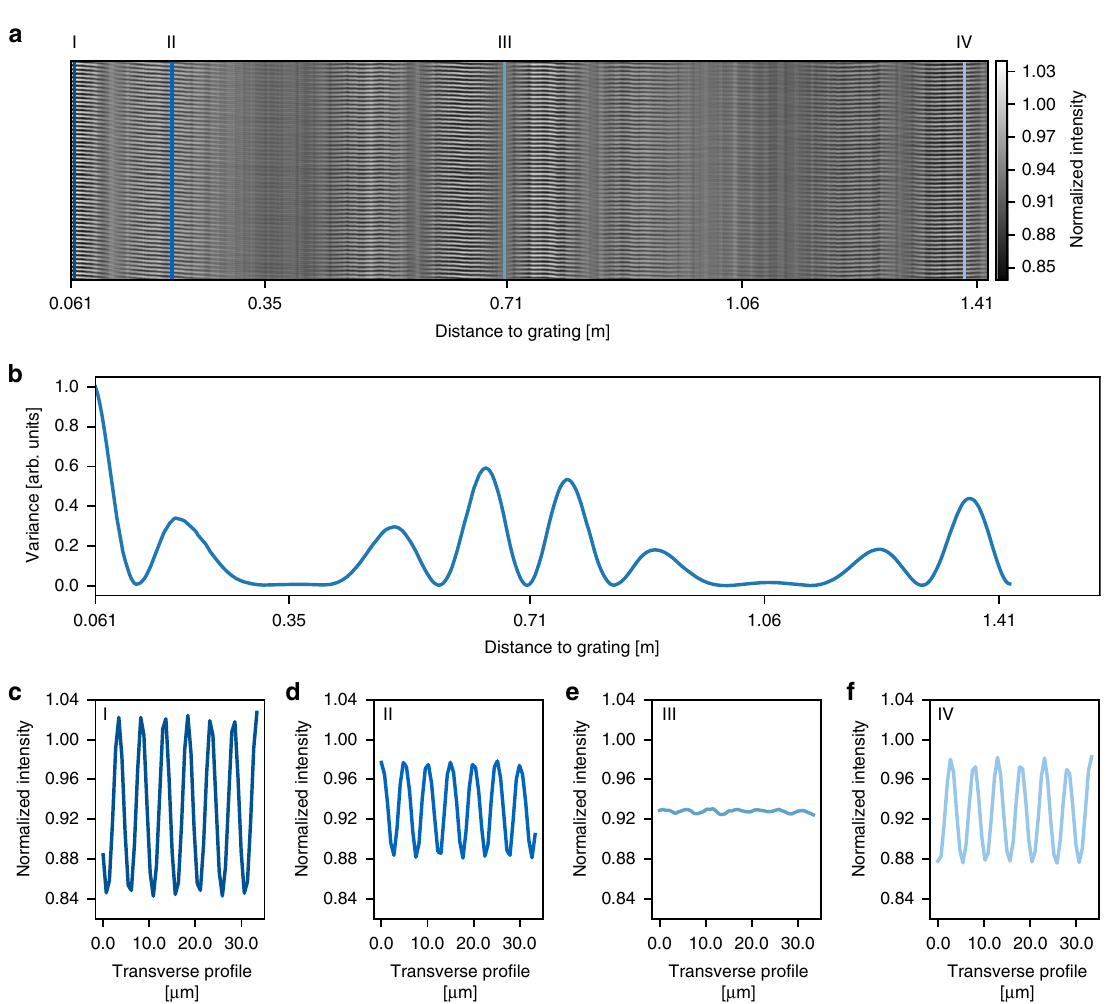
Fig. 3 Talbot-carpet of a triangular grating measured at an X-ray energy of 35 keV. The grating ’ s period is 5 μ m and its height is 32 μ m. a Measured Talbot- carpet, from 61 mm behind the grating up to one full Talbot-distance. b Variance of a transverse intensity pro fi le as a function of distance behind the grating. c Transverse intensity pro fi les through the Talbot-carpet at the specimen location (at the same position as in Fig. 1). d – f Transverse intensity pro fi les at the same positions as in Fig. 1d – f, which are also indicated by lines in the corresponding colour and Roman numerals in